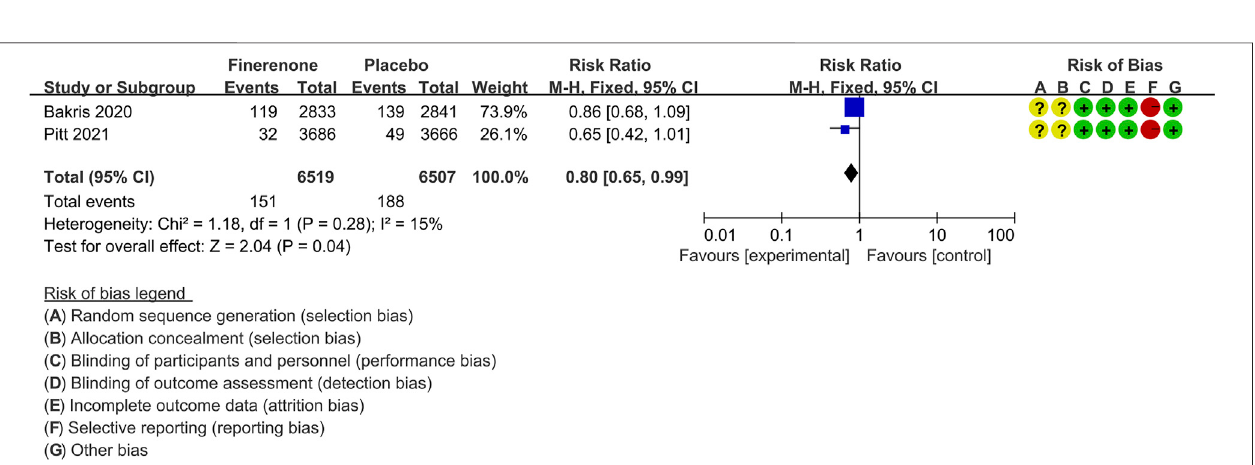
FIGURE 6 | Meta-analysis results of the ef fi cacy of fi nerenone versus placebo for end-stage kidney disease.